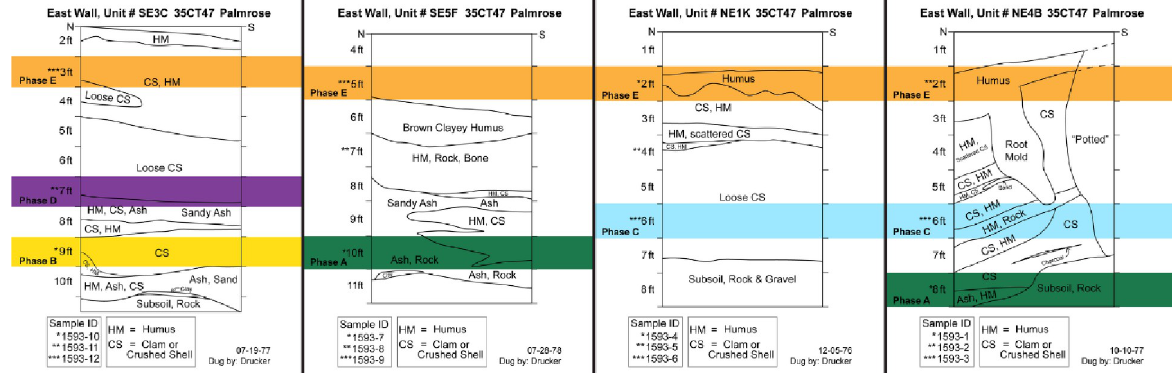
Fig 7. Unit profiles with phase designations derived from stratigraphic data from archived Phebus and Drucker field notes.